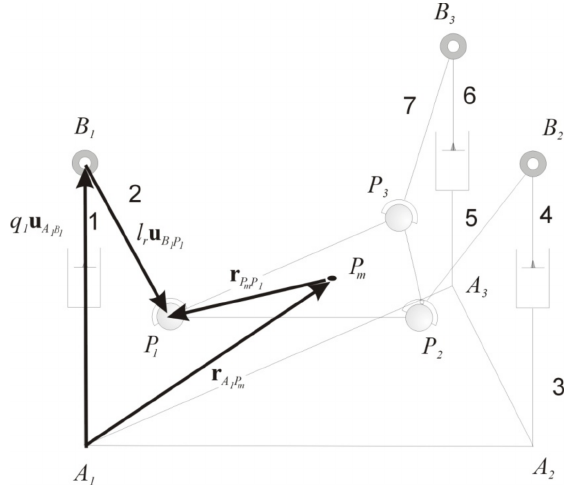
Figure 3. Closed loop for the velocity and acceleration